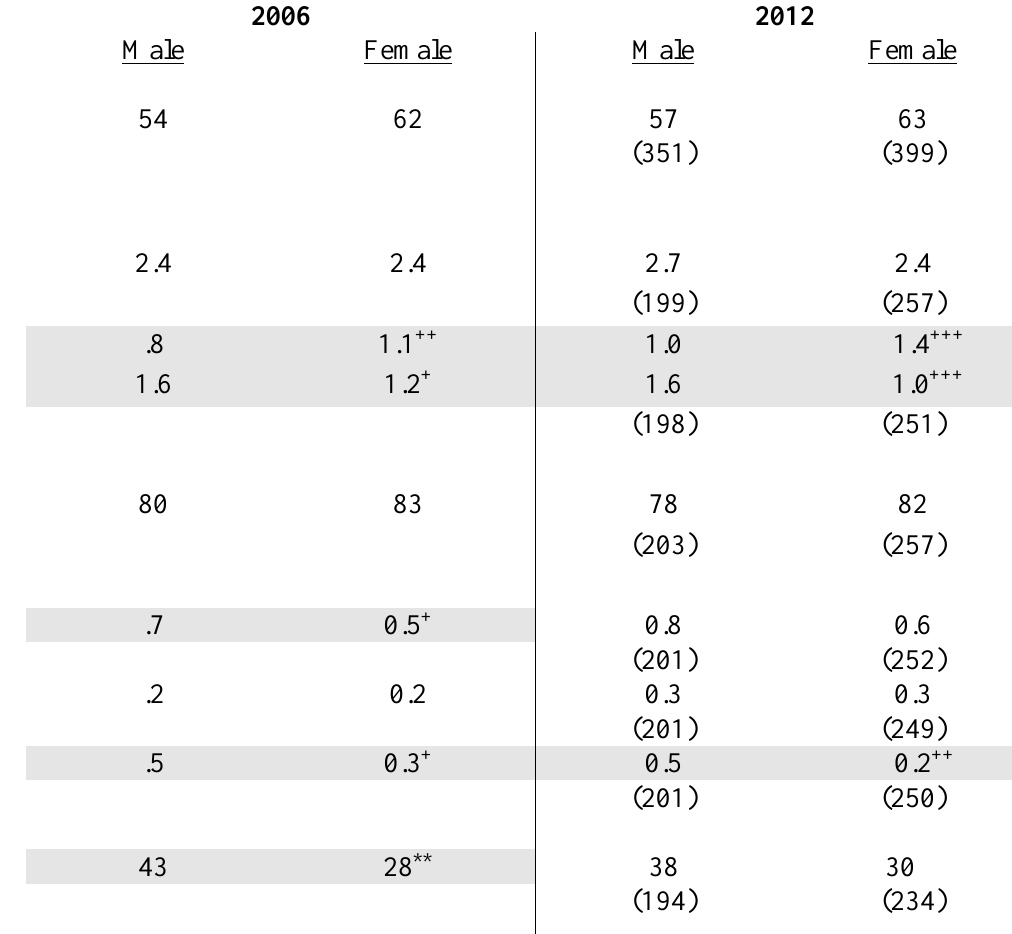
Table 26. Mentors in Current